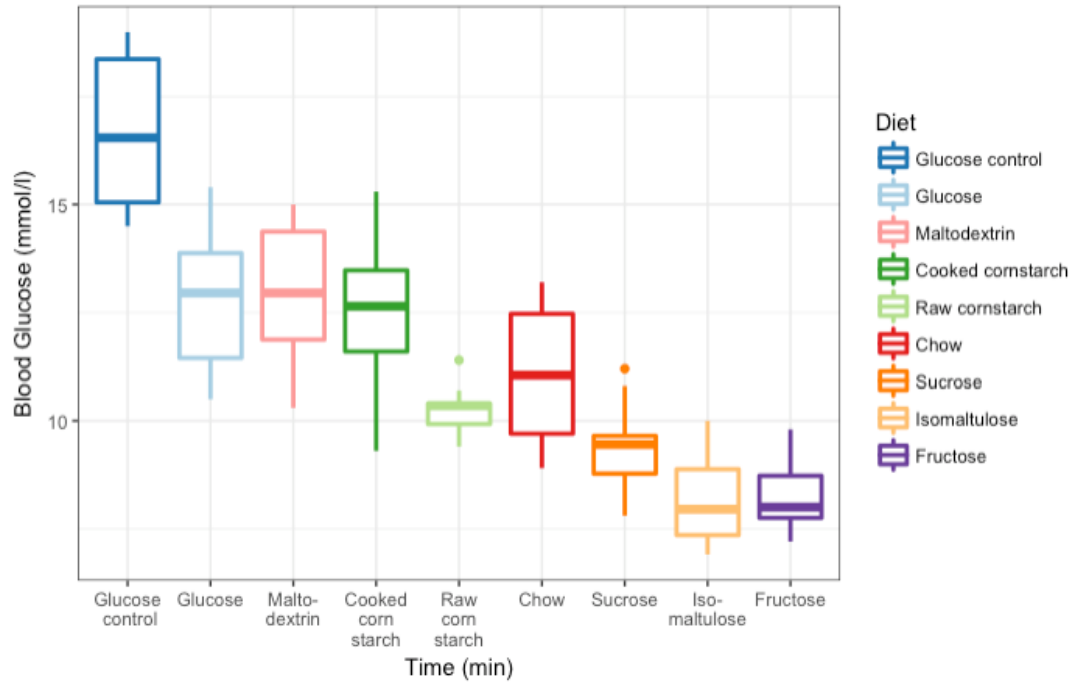
Figure 5. Boxplot of 15 min peak blood glucose during GI testing of eight diets differing in type of carbohydrate and glucose control. n = 10 female mice for each diet.